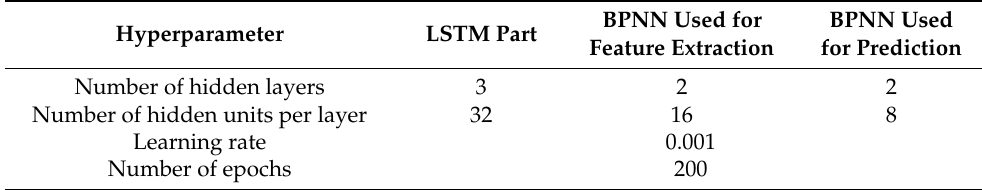
BPNN Used for BPNN Used Feature Extraction for Prediction